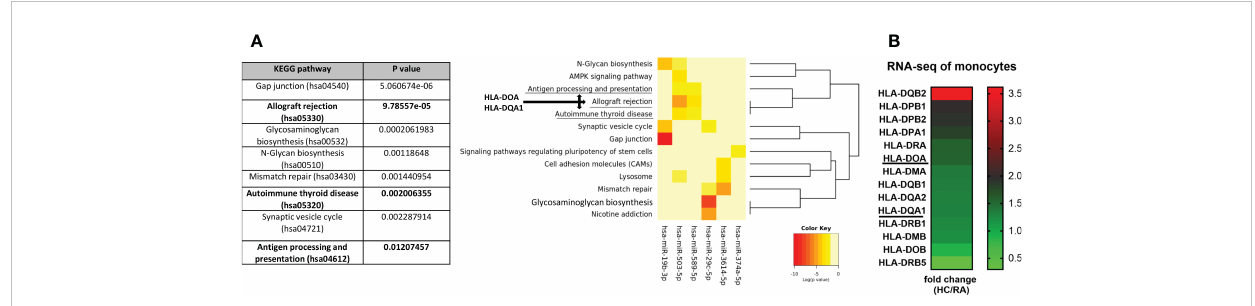
FIGURE 4 KEGG pathway analysis of selected 6 miRNA candidates and their potential target genes. The identi fi cation of speci fi c pathways (A) and their downstream genes (B) including HLA-DOA and HLA-DQA1, which were predicted to be negatively regulated by signi fi cantly changed miRNA in RA patients, using the Diana-miPath tool. The fold change analysis of expression level of HLA class II genes between HC and RA monocytes from RNA- seq (B) based of FDR < 0.01 and p-values <